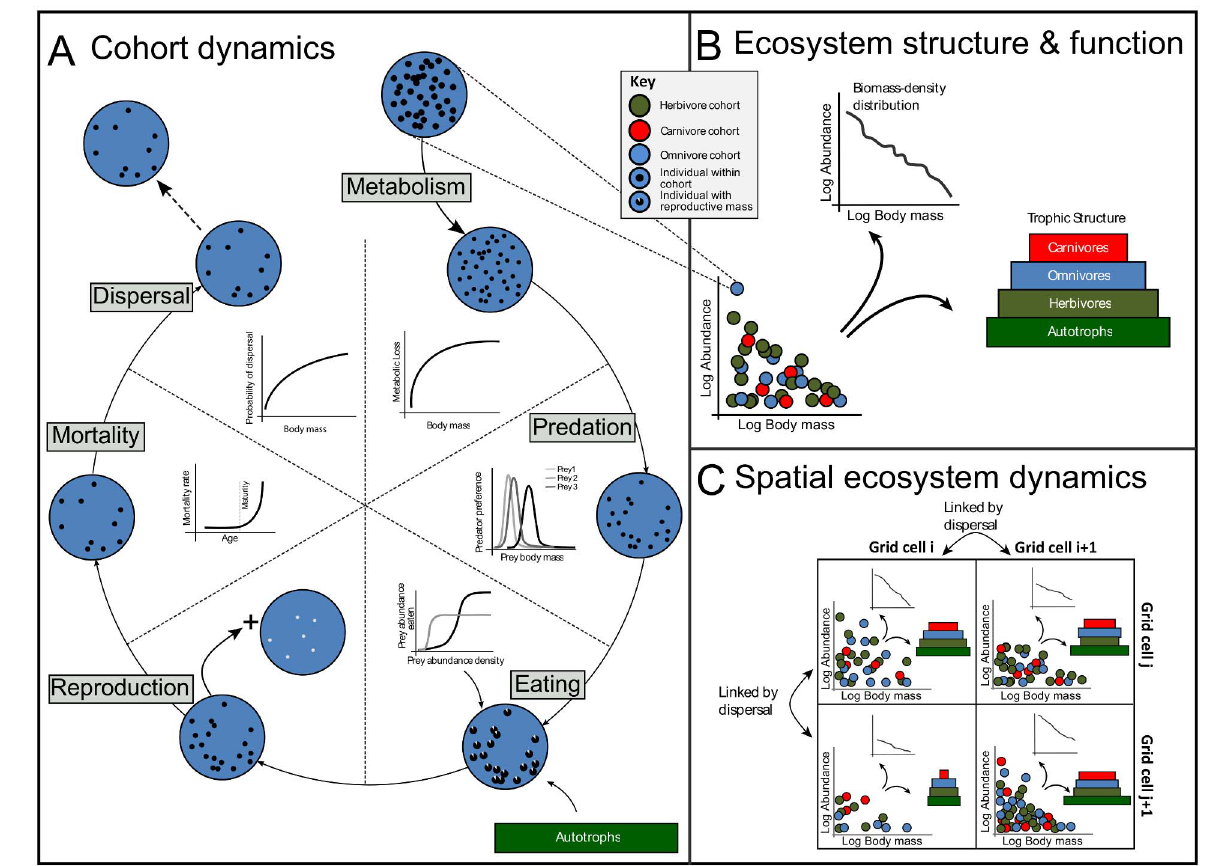
Figure 1. Schematic of the model. Ecosystem structure and function (B) emerges from a combination of processes operating on individual organisms within a grid cell (A), and exchange of individuals among grid cells via dispersal (C). Life histories (e.g., average lifespan, lifetime reproductive success, and generation length) are also emergent (not shown in this diagram, but see Figure 3). Fundamental ecological processes affect the ecological properties (principally body mass and abundance; represented as the diameter and number of black dots in A, respectively) of organisms. For computational efficiency, organisms with similar properties are grouped into cohorts (coloured circles in all panels). Graphs in (A) show illustrative examples of functional forms used to model each ecological process; full mathematical details can be found in the main text and in Text S1. Panel (C) illustrates how dispersal links different grid cells through the exchange of cohorts via dispersal. As result of the within-grid-cell processes, and dispersal, the state of the ecosystem—that is, the collection of cohorts within each grid cell—changes dynamically through time. Panel (B) shows two example measures of ecosystem structure that can be calculated at any time: the relative biomasses in different trophic levels, and the body-mass abundance distribution of heterotrophs. All such community-level properties and metrics emerge from bottom-up processes in the model without any model-imposed constraints beyond those processes operating on individual organisms.